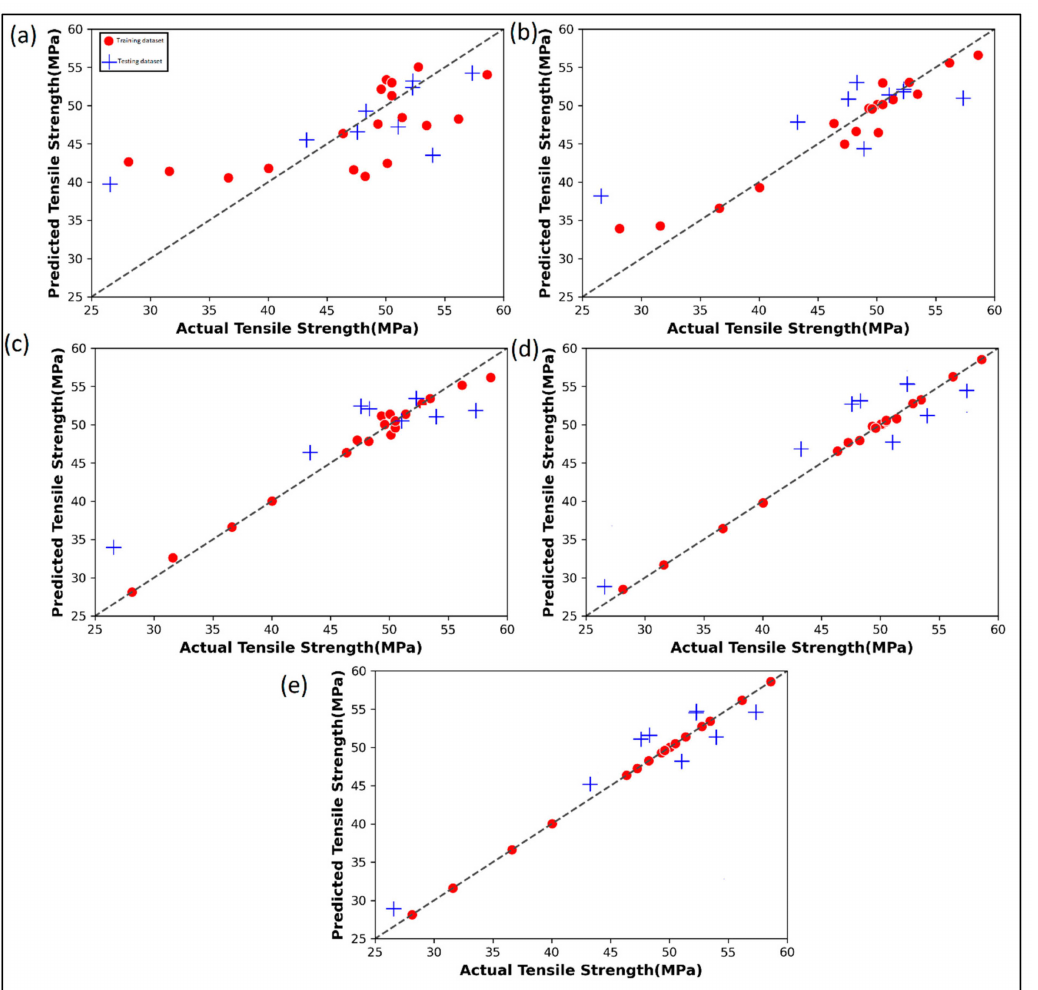
Figure 4. Actual versus predicted tensile strength by various ML algorithms: ( a ) Linear regression; ( b ) Random Forest regression; ( c ) AdaBoost regression; ( d ) Gradient boost regression; ( e ) XGBoost regression for case study